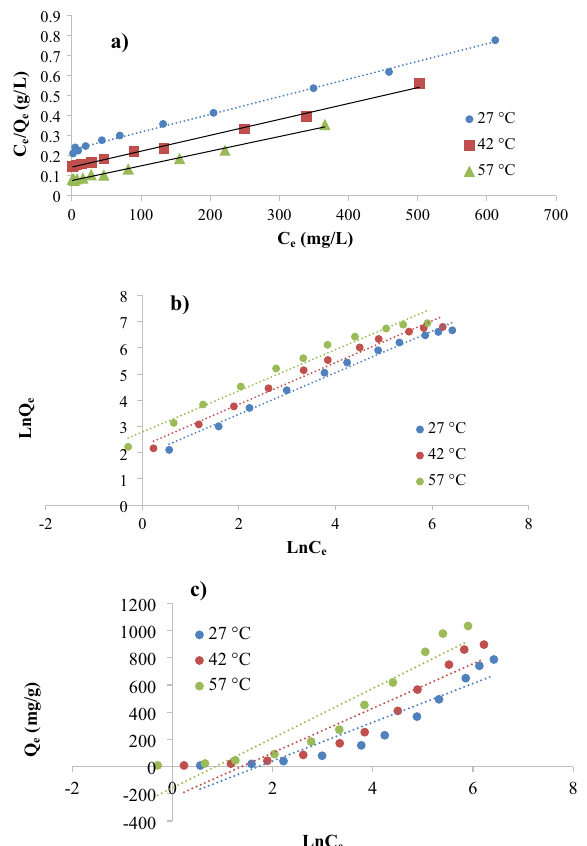
Figure 8. ( a ) Langmuir and ( b ) Freundlich and ( c ) Temkin isotherm models for adsorption of KMnO 4 by Ox-FVESP.